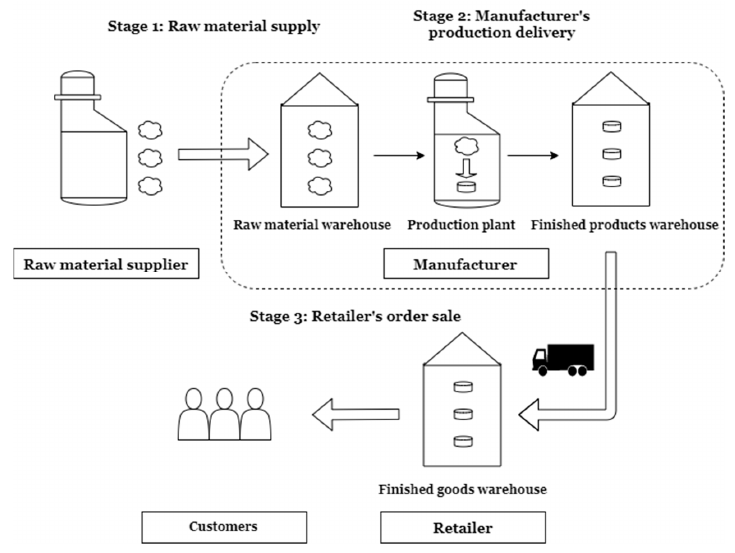
Figure 1. Schematic diagram of the proposed multistage supply chain system.